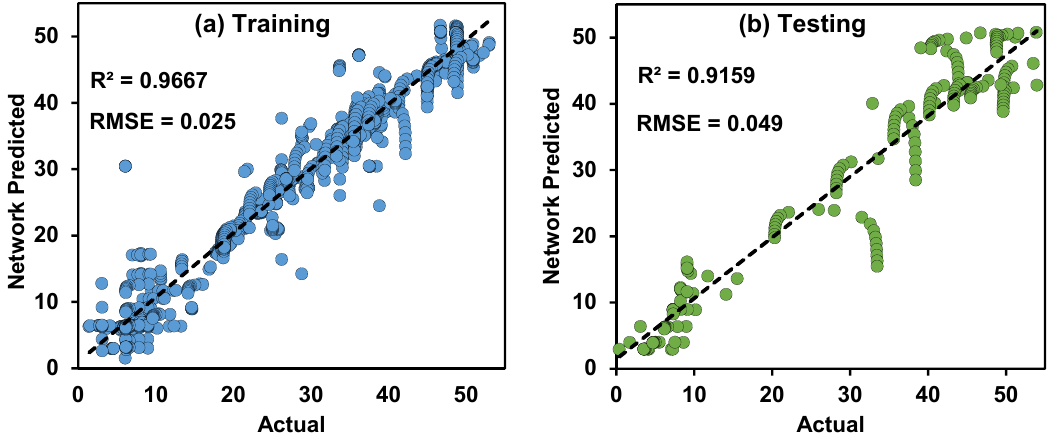
Figure 8. Linear activation function used to calculate the battery output data for the NN 1 model in ( a ) training and ( b ) testing.